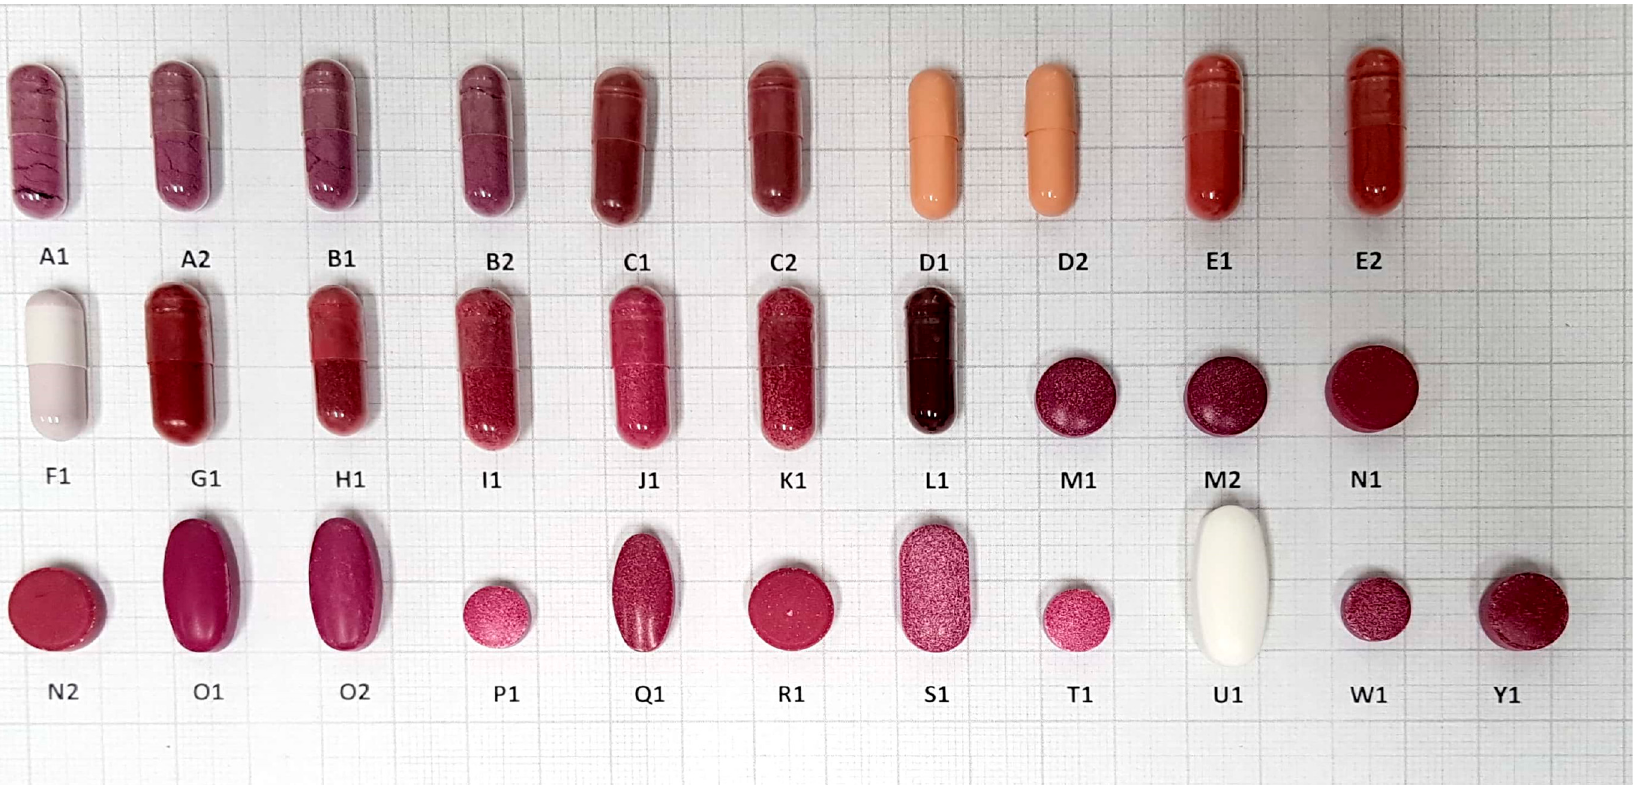
Figure 2. Variation of sizes and shapes of the analyzed dietary supplements.